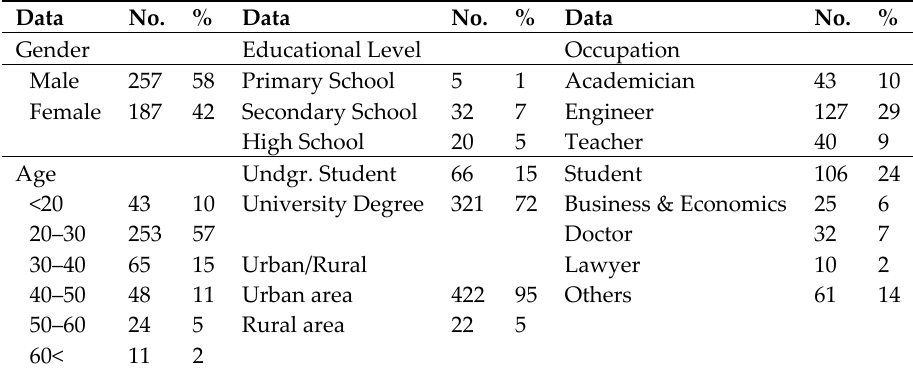
Table 2. Demographic data of the participants.